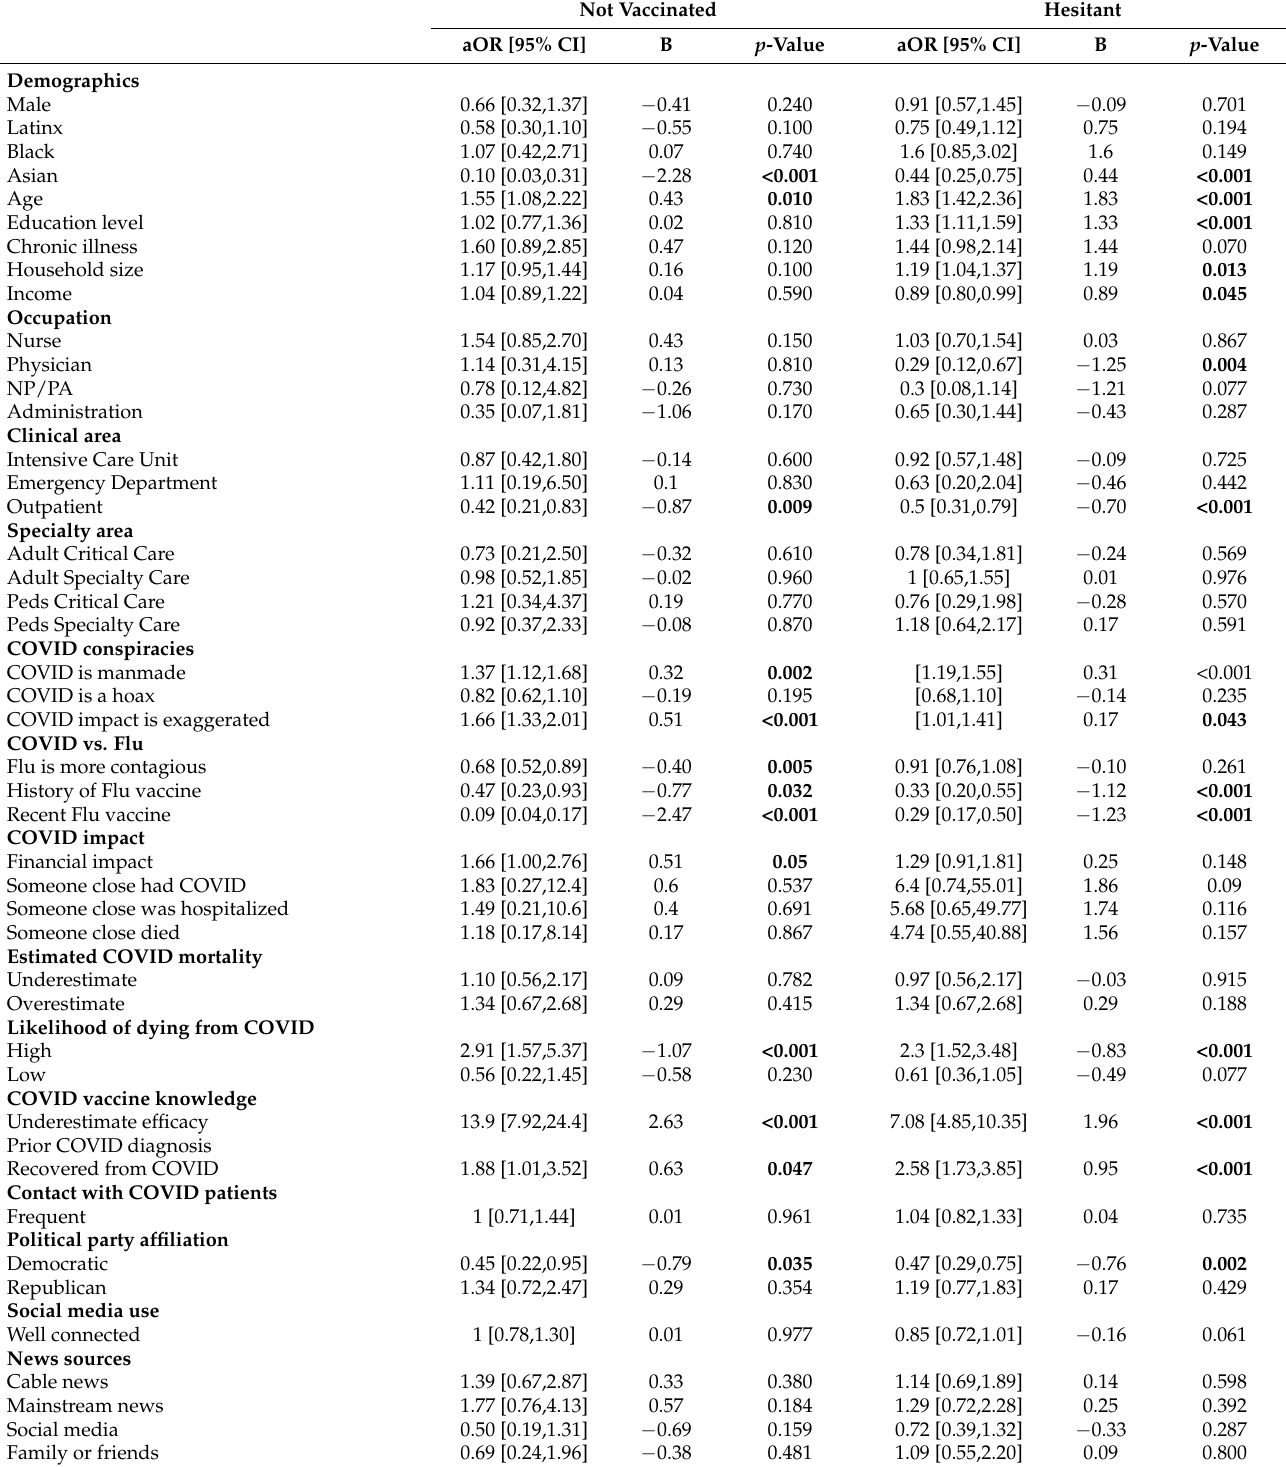
Table 4. Predictors of vaccination